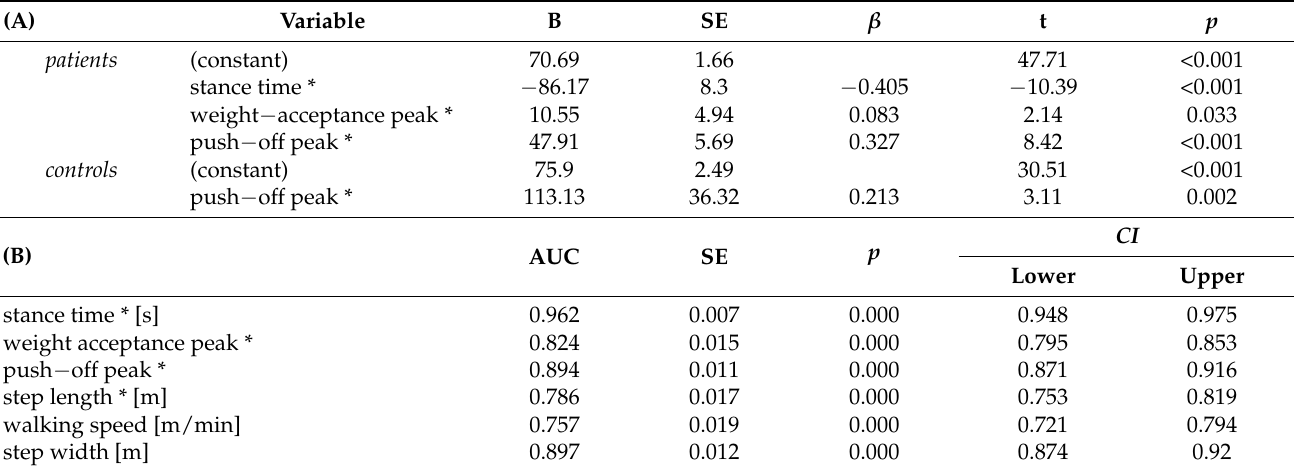
Table 3. Regression analysis summary of kinetic gait parameters predicting walking speed ( A ) and summary of ROC analysis ( B